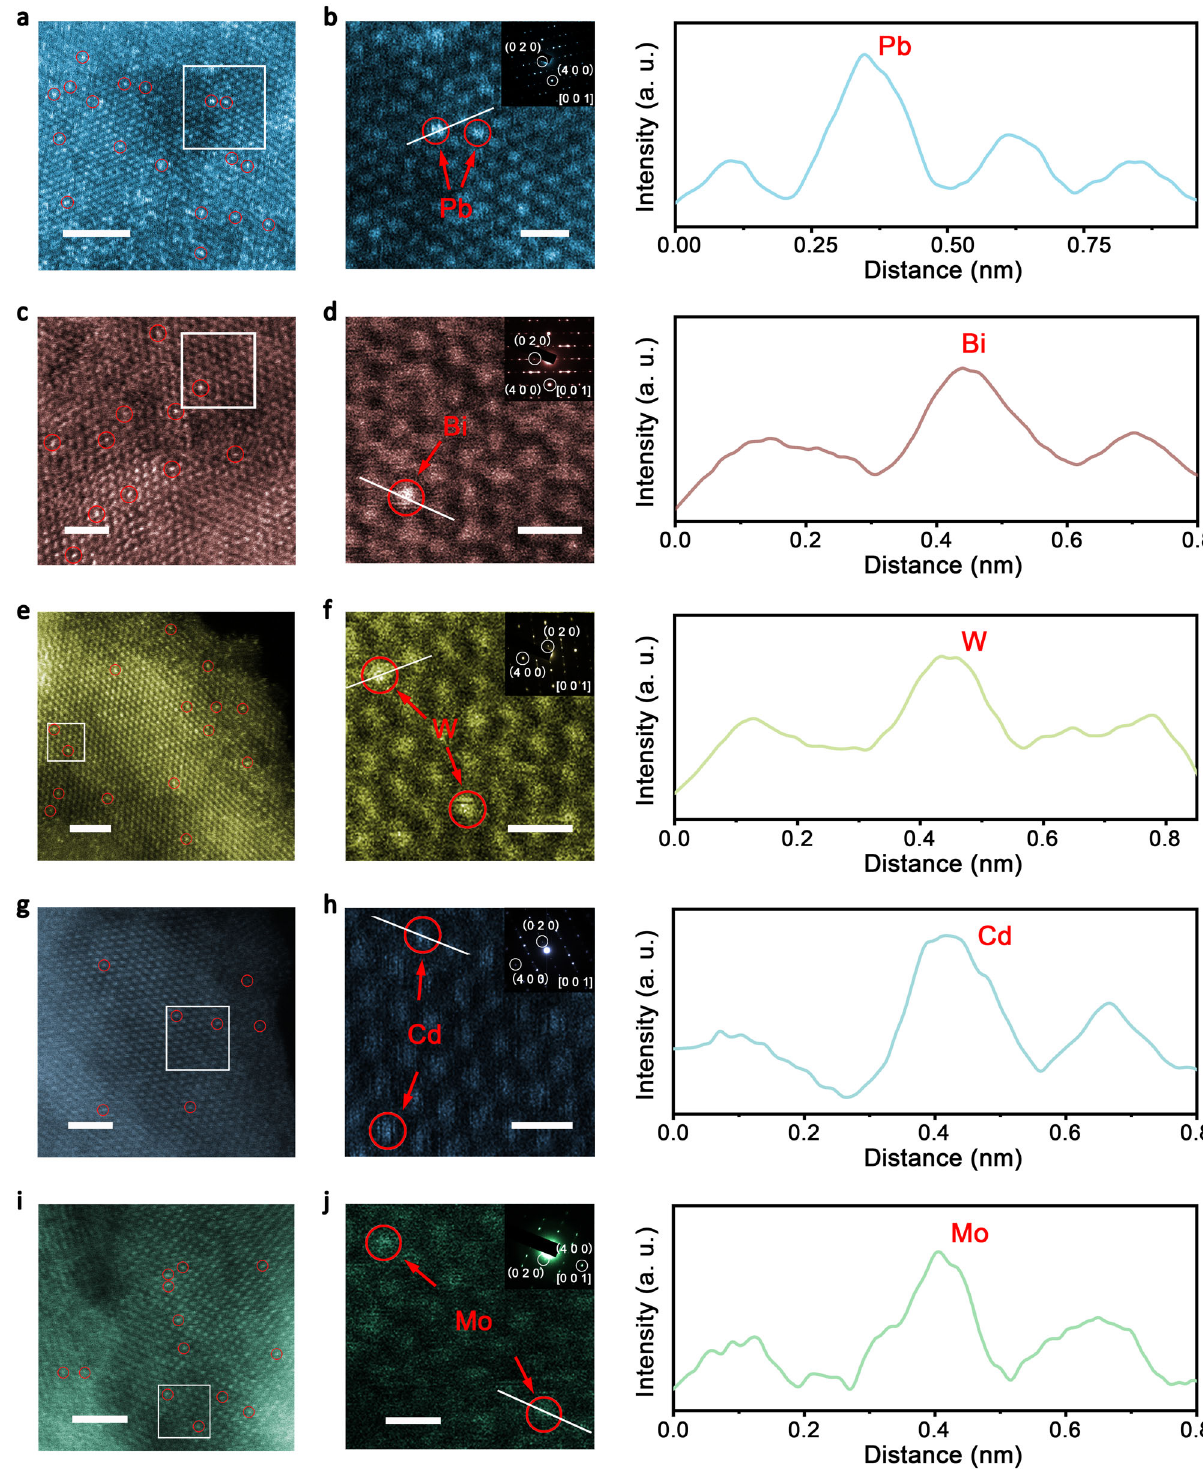
Fig. 3 | Aberration-corrected STEM images. Atomic-resolution STEM images ( a , c , e , g , i , scale bars, 1nm) and enlarged images of white rectangles ( b , d , h , f , j , scale bars, 0.5nm) of Pb-, Bi-, W-, Cd- and Mo-CoSe 2 -DETA nanobelts,